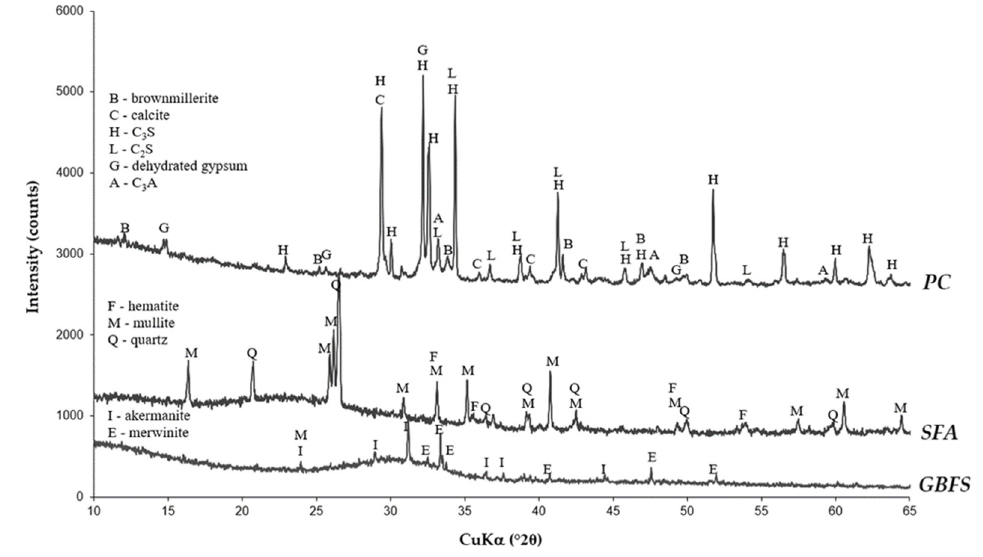
Figure 1. XRD patterns of PC, GBFS and SFA. Table 2. Compositions of the cement mixtures